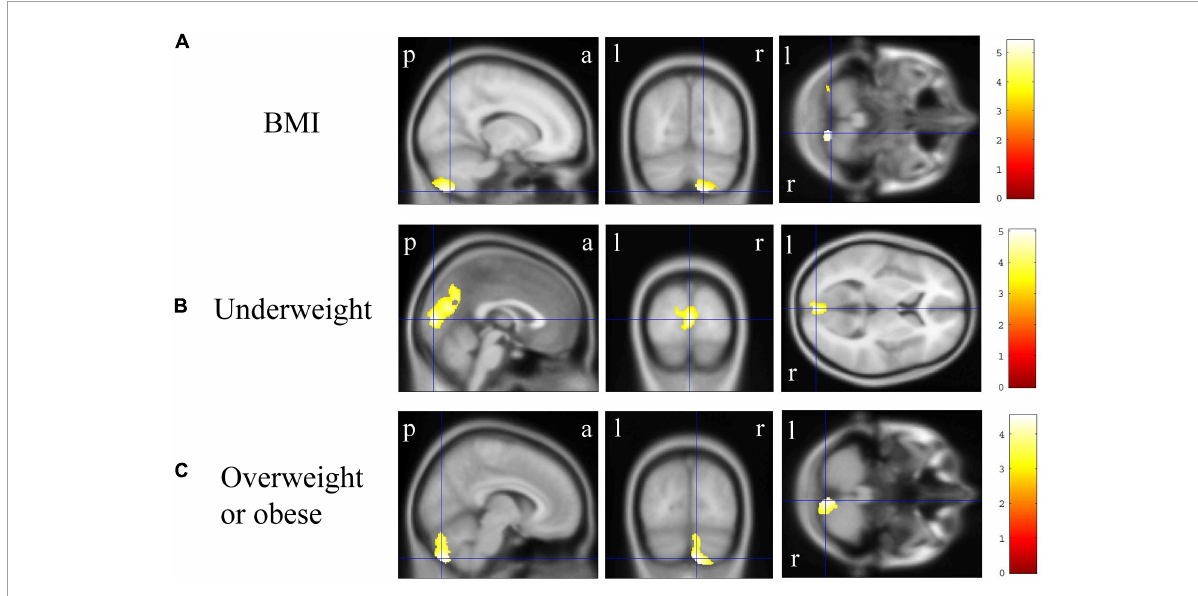
FIGURE2 Gray matter regions where the volume was associated with body mass index (BMI), underweight, and overweight or obese individuals. (A) BMI was negatively correlated with gray matter volumes in the bilateral cerebellum exterior [ p < 0.01 corrected, Montreal Neurological Institute (MNI) 152 T1 atlas coordinates: x = 15.0 mm, y = − 70.5 mm, z = − 58.5 mm indicated by blue cross-hair lines]. (B) Gray matter volume in the bilateral cuneus and calcarine cortex, left cuneus, and left precuneus was reduced in underweight individuals when compared with that in non-underweight individuals ( p < 0.001 corrected, MNI 152 T1 atlas coordinates: x = 0.0 mm, y = − 88.5 mm, z = 6.0 mm indicated by blue cross-hair lines). (C) Gray matter volume in the right cerebellum exterior was reduced in overweight or obese individuals when compared with that in underweight or normal individuals ( p < 0.05 corrected, MNI 152 T1 atlas coordinates: x = 7.5 mm, y = − 79.5 mm, z = − 51.0 mm indicated by blue cross-hair lines). Right-sided gradient color bars represent t -scores. a, anterior; l, left; p, posterior; r, right.